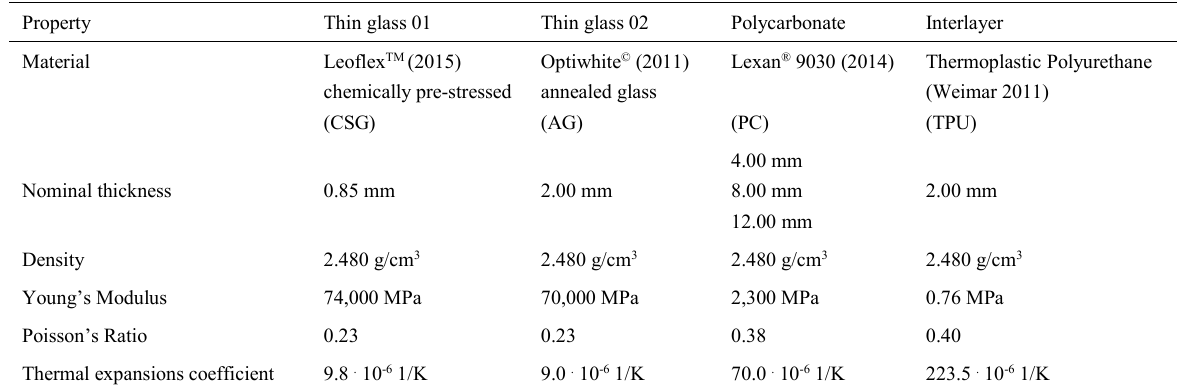
Table 1: Material properties of a thin glass-polycarbonate composite